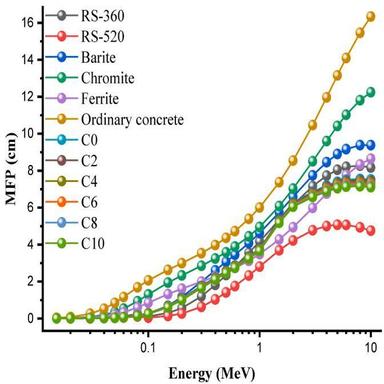
Variation of mean free path (MFP) against photon energy for the glasses and some traditional shielding materials.